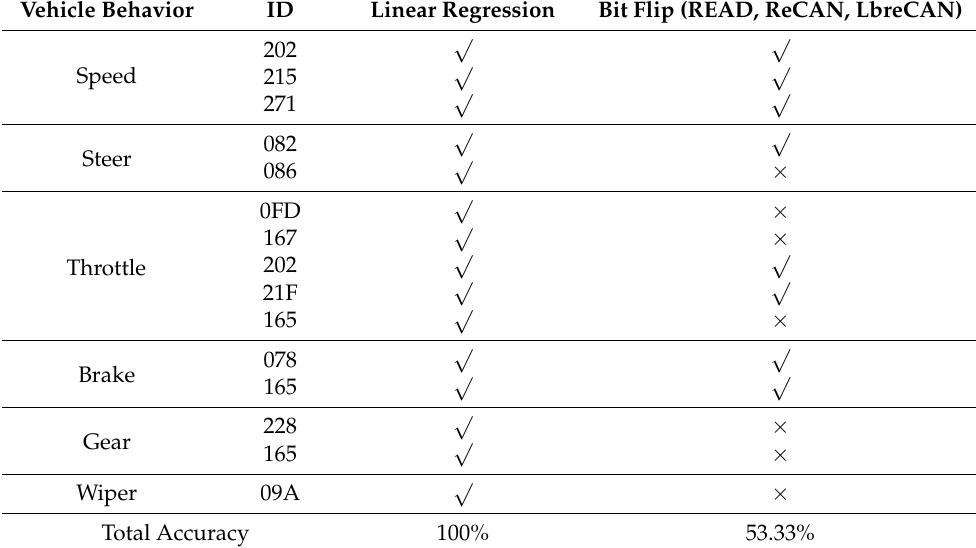
Table 10. Boundary Delineation